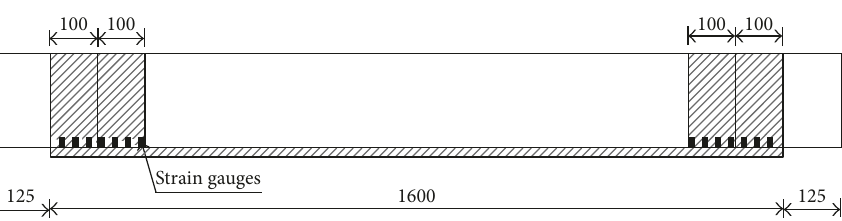
Figure 5: CFL wrapping and strain